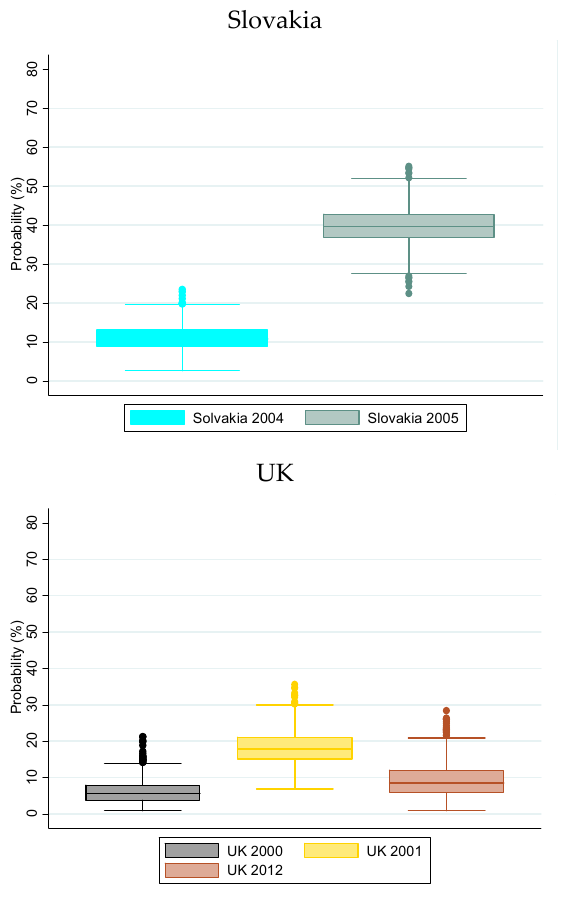
Figure 2. Probability of finding non-compliant feed products per country and year.